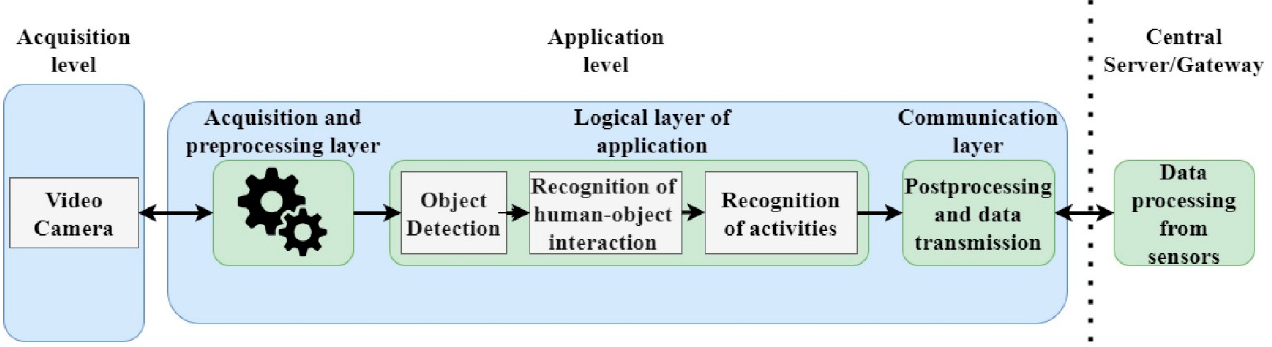
Figure 7. HAR module communication